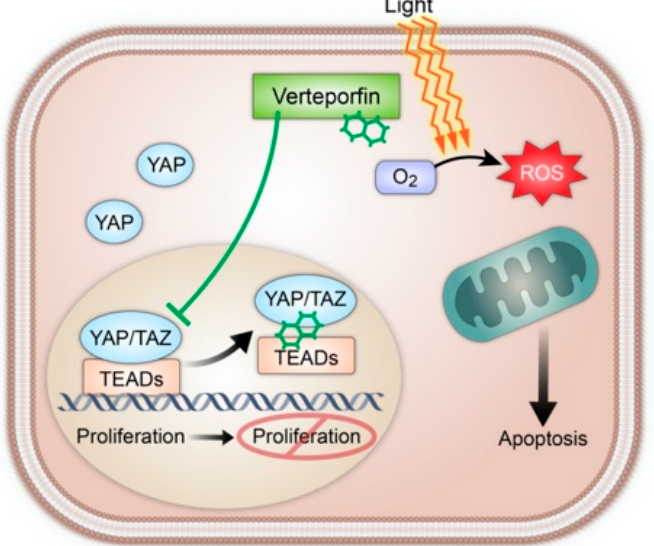
Figure 2. A demonstration of Verteporfin dual mechanism via YAP/TAZ interaction leading to decreased cellular proliferation (left) and induction of cellular apoptosis following light activation leading to oxidative damage (right).